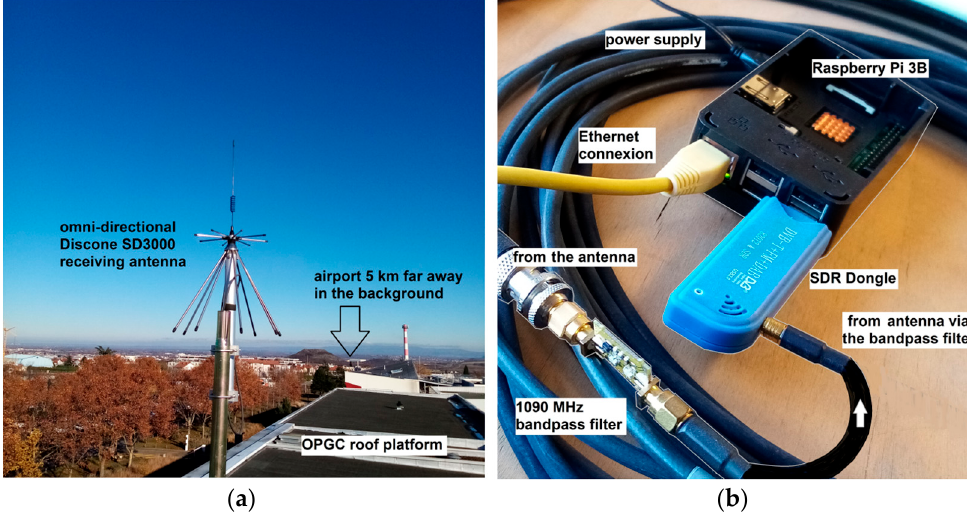
Figure 2. General view of the outdoor ( a ) and indoor ( b ) hardware with SDR Dongle and Raspberry Pi.